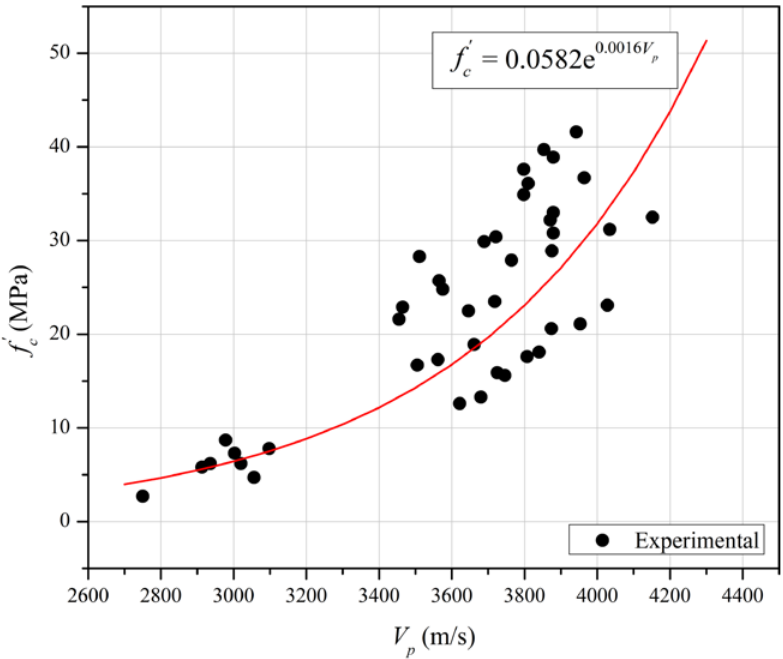
Figure 6. The single exponential function correlation between ultrasonic pulse velocity ( V p ) and compressive strength ( f (cid:48) c ) from day 1 up to day 28.